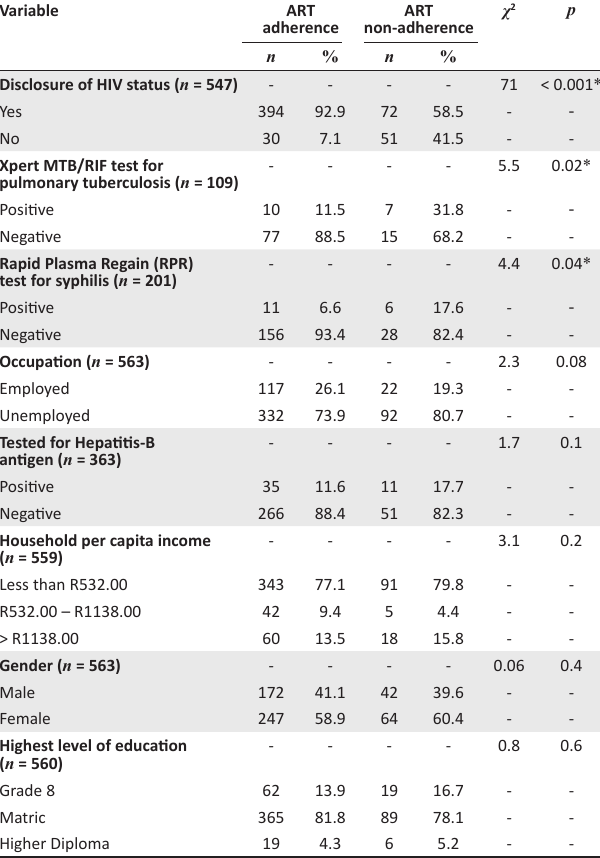
TABLE 3: Bivariate analysis of antiretroviral treatment adherence and participants’